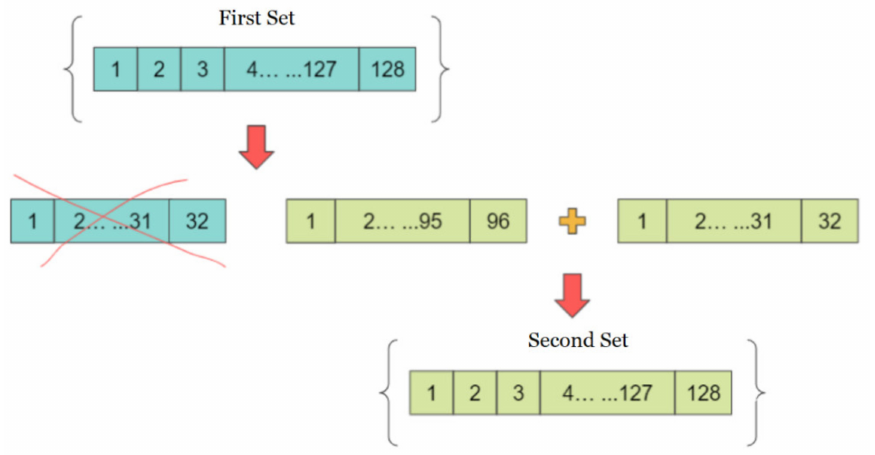
Figure 5. Data packaging